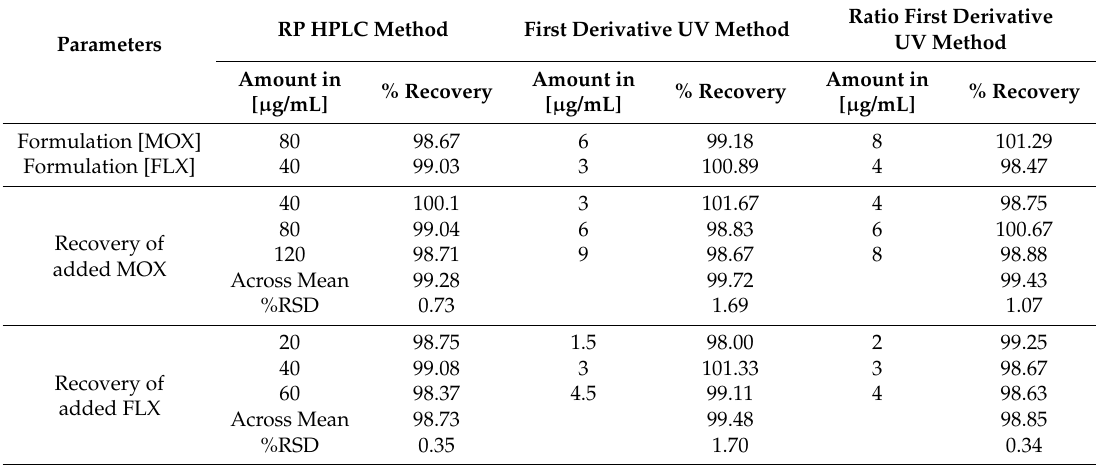
Table 3. Determination of MOX and FLX from formulations and recovery studies by standard addition method.